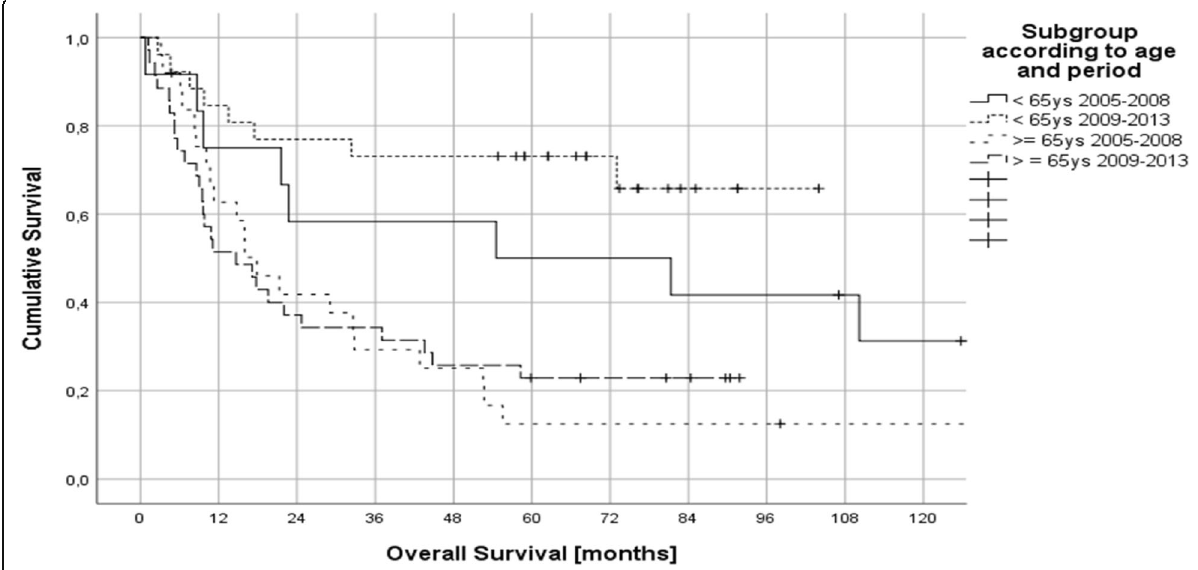
Fig. 3 Overall survival according to age and treatment period (group A: <65 ys 2005 – 2008 received liposomal Ara C i.th.; group B: <65 ys 2009 –